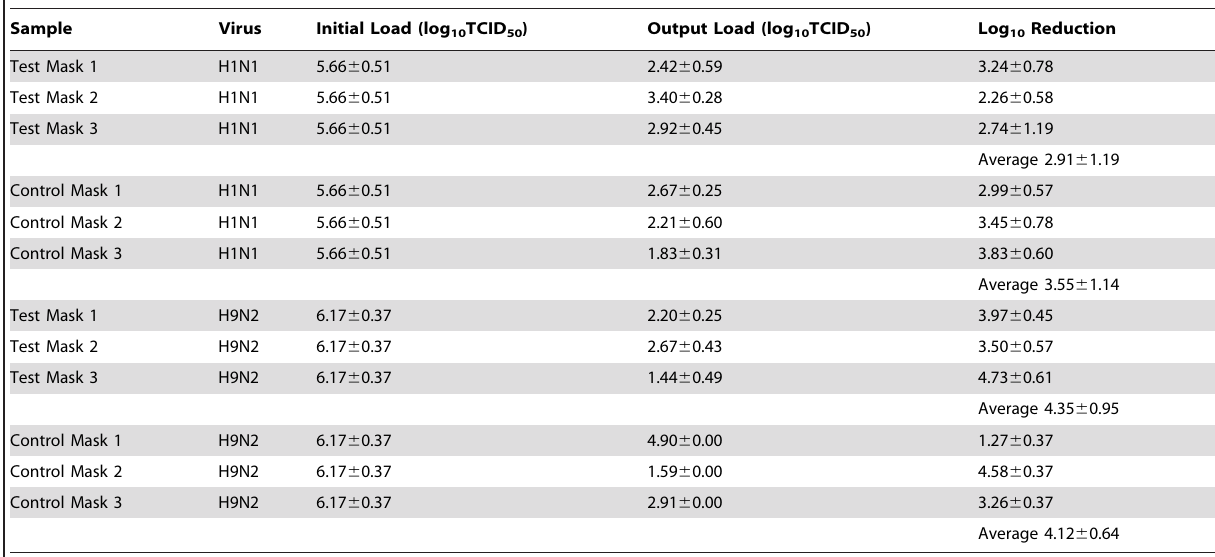
Table 1. Pass Through a Infectious